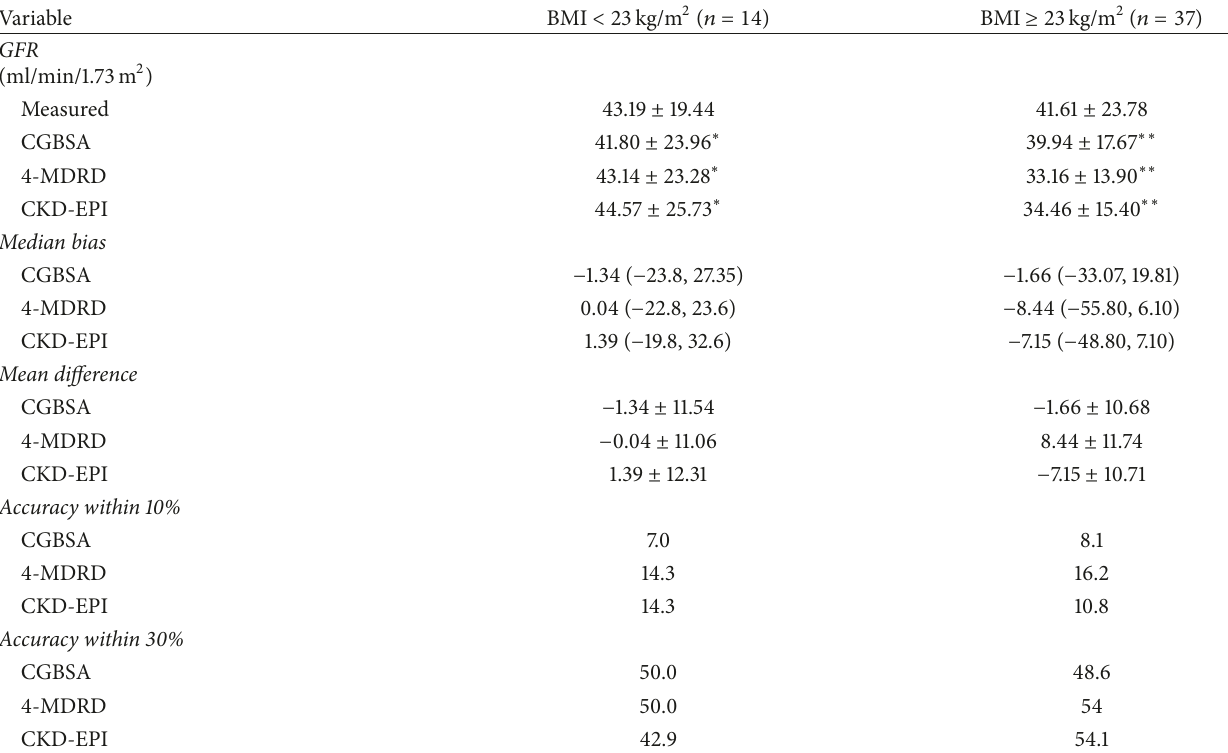
∗ Mean CGBSA GFR versus measured GFR 𝑝 = 0.672 , mean 4-MDRD GFR versus measured GFR 𝑝 = 0.989 , and mean CKD-EPI GFR versus measured GFR 𝑝 = 0.680 . ∗∗ Mean CGBSA GFR versus measured GFR 𝑝 = 0.350 , mean 4-MDRD GFR versus measured GFR 𝑝 < 0.001 , and mean CKD-EPI GFR versus measured GFR 𝑝 < 0.001